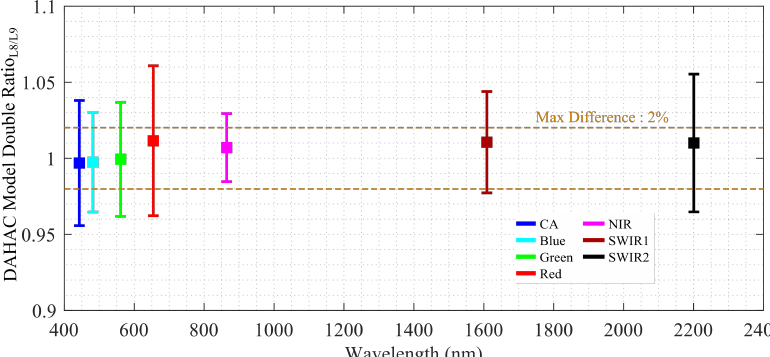
Figure 27. Double ratio between L8 and L9. Orange dotted lines show a maximum 2% differences between L8 and L9.